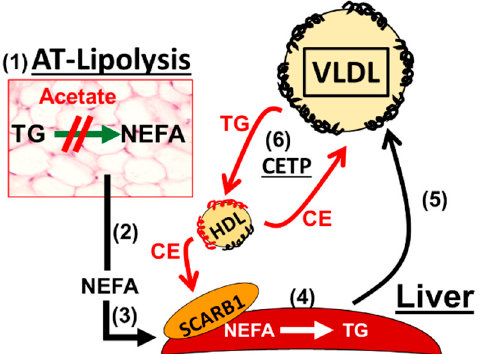
Figure 4. Mechanistic model for acetate-mediated alteration of the plasma lipoprotein profile (see text for details). Adipose tissue (AT), very-low-density lipoproteins (VLDL), cholesteryl ester transfer protein (CETP), cholesteryl ester (CE), non-esterified fatty acids (NEFA), high-density lipoproteins (HDL), triglycerides (TG), scavenger receptor class B member 1 (SCARB1). 9. Acetate in Foods